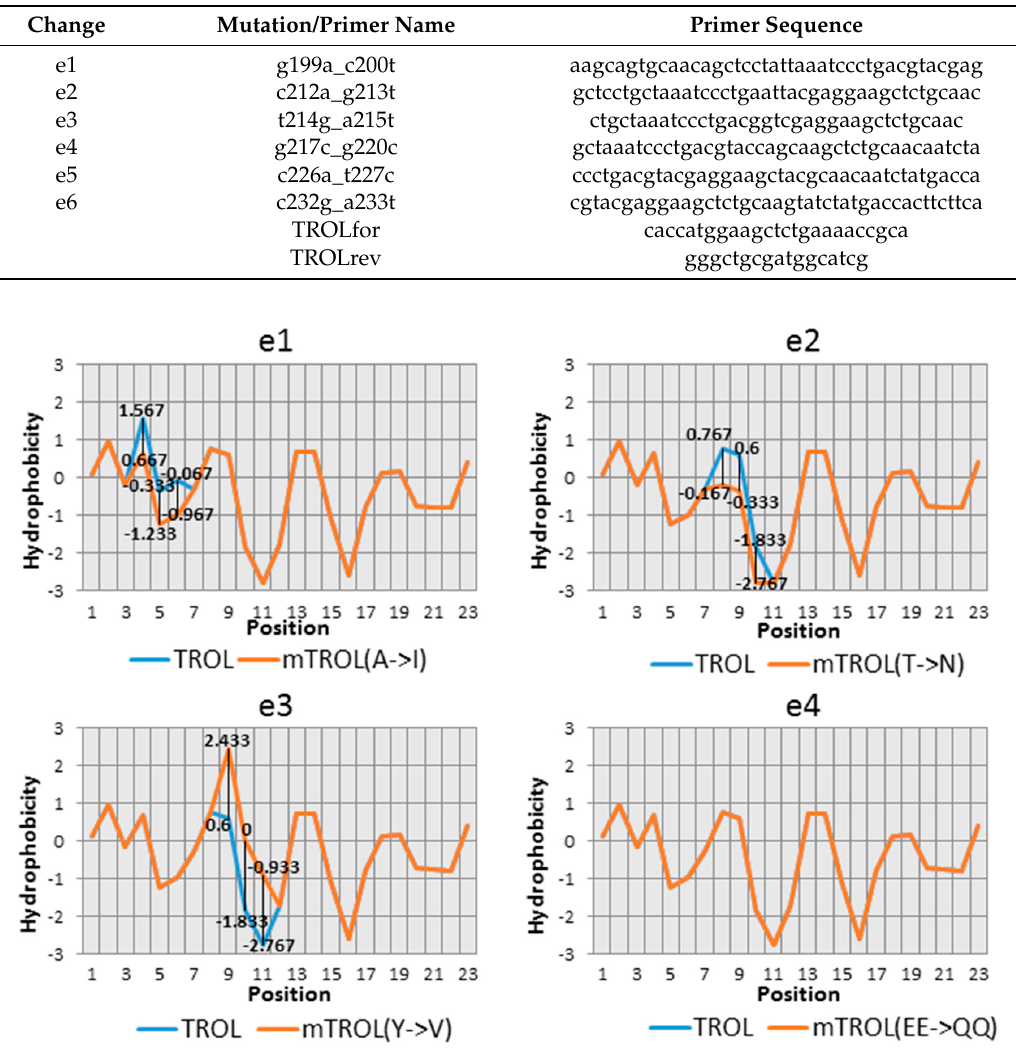
Table 1. Mutations introduced to the TROL presequence by the QuikChange Multi Site-Directed Mutagenesis and corresponding primer